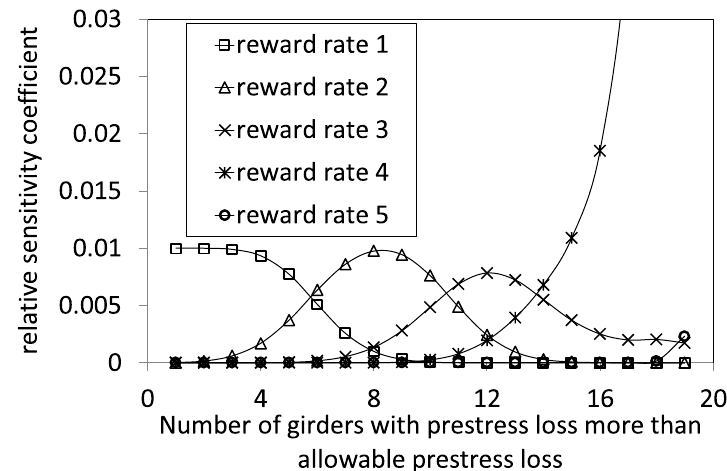
Fig. 6 Variation in relative sensitivity of performability with reward rate for different initial